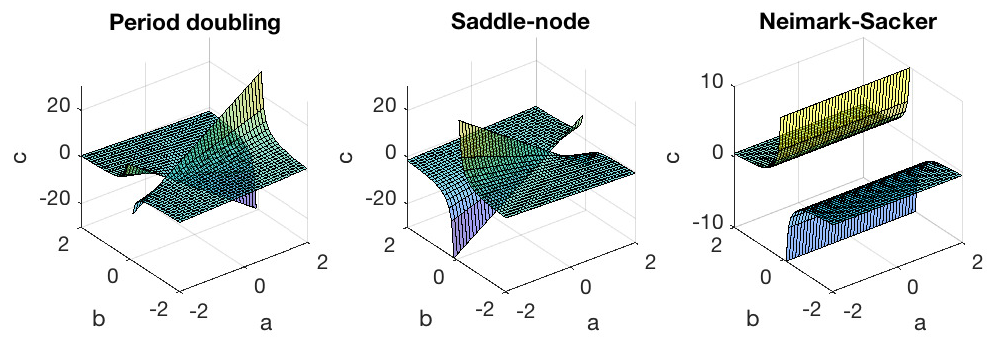
Figure 2. ( left ), ( middle ), ( right ) show the three bifurcation conditions in Equation (16) represented in the space ( a , b , c